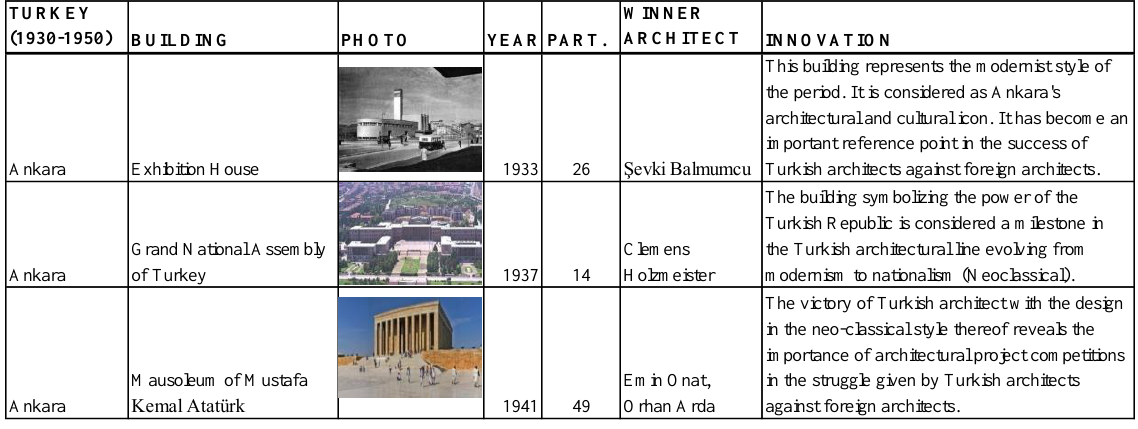
Table 6. Selected competition examples of 1930-1950